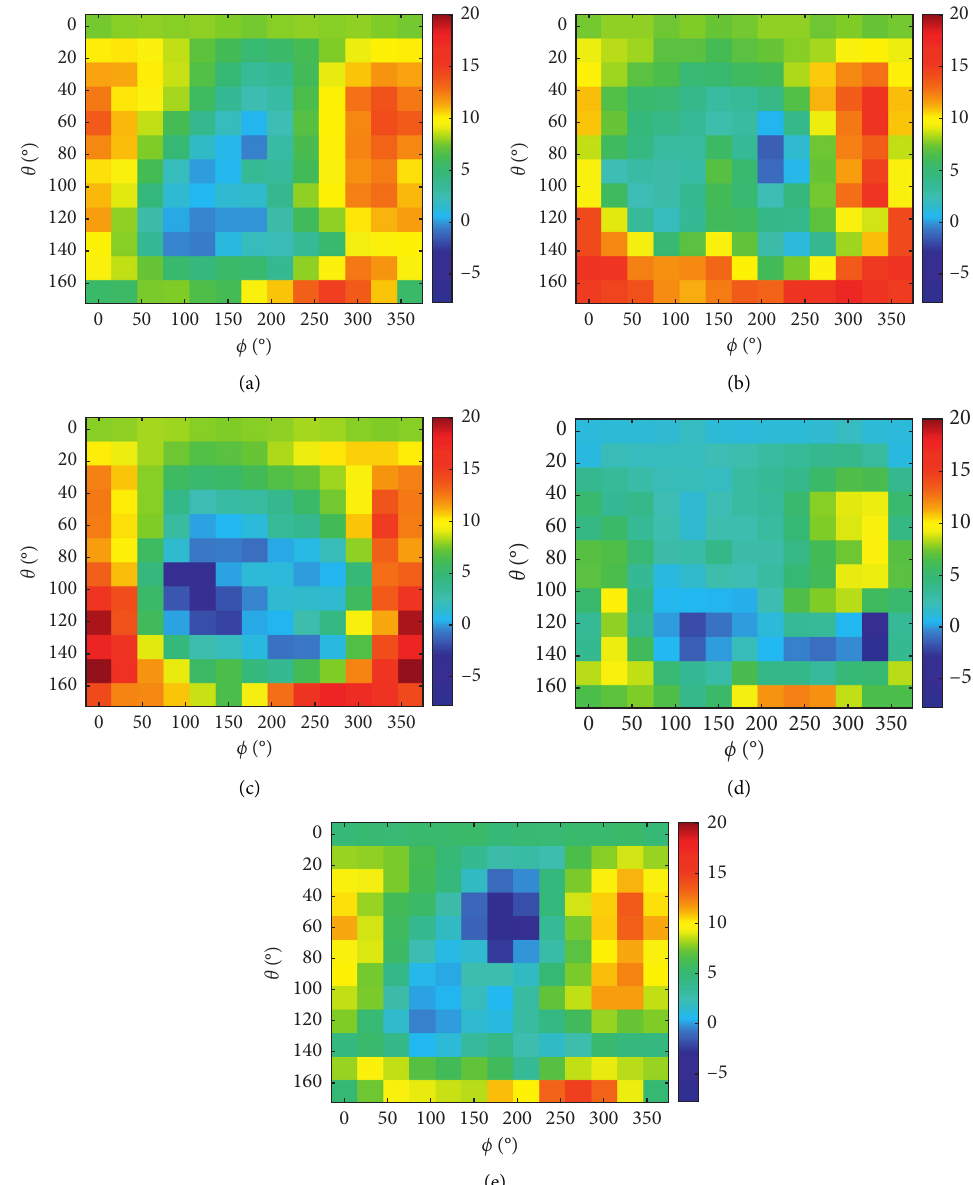
Figure 8: Mean body loss pattern (in dB) at 2.406GHz: (a) Beoplay E8 2.0; (b) Earin M2; (c) Bose soundsport free; (d) Apple airpods 2; (e) Beoplay E8 3rd gen. Table 3: Results for the evaluated body loss for the earbuds. Body loss (dB) Earbud 2.406GHz 2.476GHz Min Mean Max Min Mean Max Beoplay E8